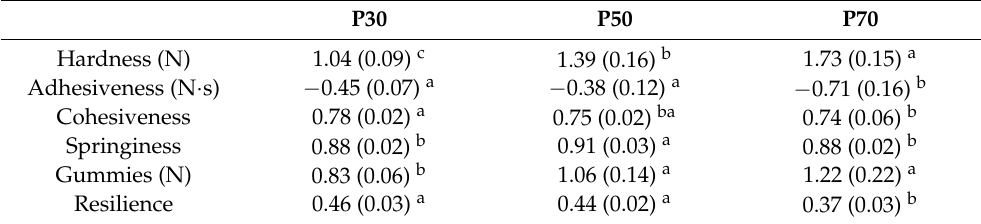
Table 6. TPA test